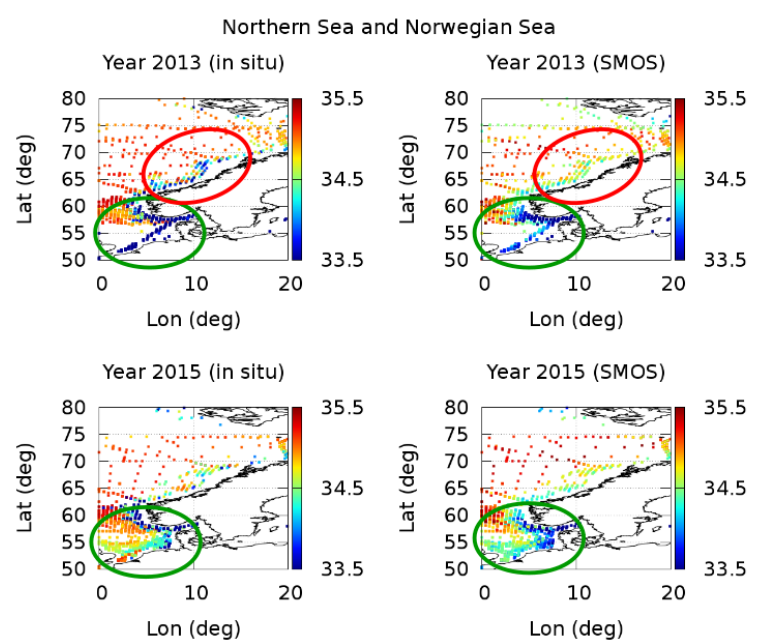
Figure 7. TSG ( left column ) and SMOS ( right column ) SSS in the Northern and Norwegian Seas for 2013 ( top ) and 2015 ( bottom ).